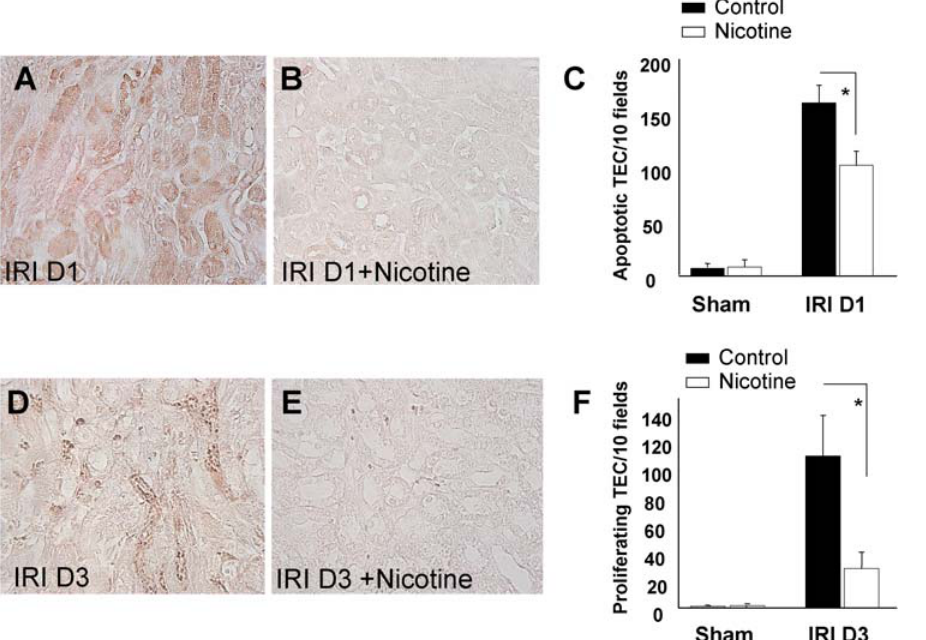
Figure 5. Nicotine reduces tubular epithelial cell apoptosis and subsequent proliferation. Immunostaining of cleaved caspase-3 (A, B) and Ki67 (D, E) were performed one day and 3 days after I/R, respectively. Panel A represents TEC apoptosis in saline-treated animals (magnification 6 40) and panel B represents TEC apoptosis in nicotine pre-treated animals (magnification 6 40). Graph C compares the quantification of apoptotic TECs in saline-treated (black bars) or nicotine-treated animals (white bars), either after sham operation (n=6 in each group) or renal I/R (n=7 in saline-treated group and n=10 in nicotine pretreated group). Panels D and E compare Ki-67 + cells between saline-treated animals and nicotine-treated animals (magnification 6 40). Graph F compares the quantification of proliferation 3 days after reperfusion (n=5 in each group). Data are expressed as mean 6 SEM, (*) p # 0.05. doi:10.1371/journal.pone.0000469.g005 PLoS ONE |